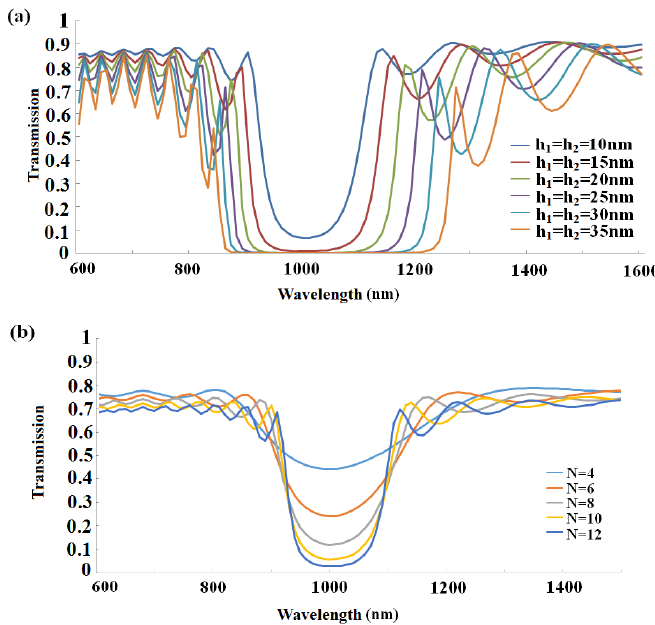
Figure 3. Transmission spectra of the MIM-based sensor as a function of wavelength ( a ) transmission spectra with different air groove grating depth when period number n = 8, groove width w 1 = w 2 = 200 nm; ( b ) transmission spectra with different period numbers, with groove depth h = 10 nm, groove width w 1 = w 2 = 200 nm.